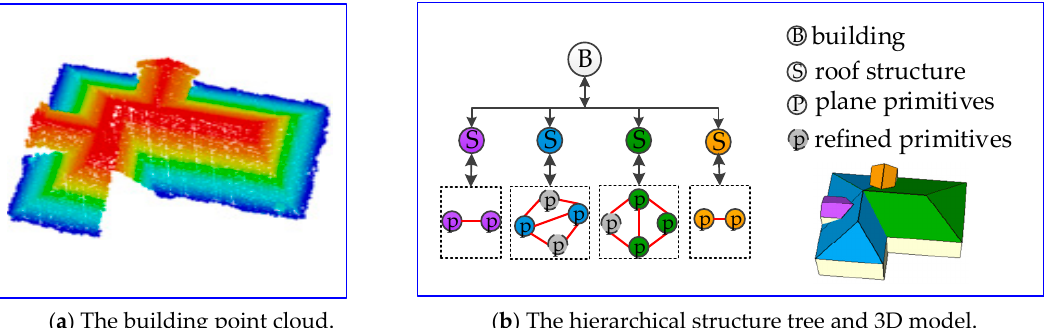
Figure 11. The final hierarchical structure model after the enhancement. ( a ) Original building point cloud; ( b ) the refined structures and updated graph.